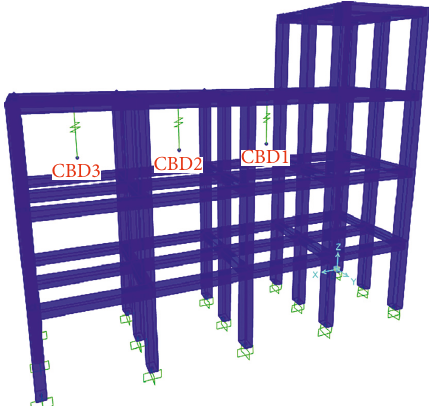
Figure 16: Finite element model of the subject